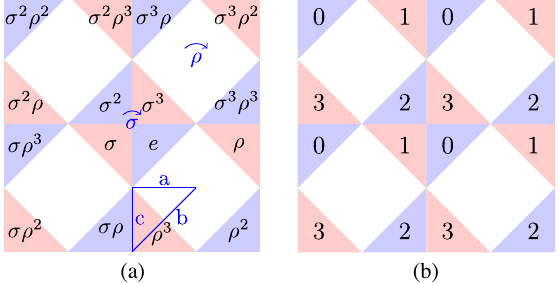
FIG. 25. An L ¼ 2 subsystem surface code. (a) After associat- ing a triangle operator with the identity element e , every triangle operator is in one-to-one correspondence with an element of the proper symmetry group G H þ 4 of the tessellation. In blue we label a ; 4 fundamental triangle with sides a , b , and c , as well as the rotations ρ ¼ ab and σ ¼ bc . (b) Each triangle operator can be labeled with an element of the cyclic group Z 4 using the to Z 4 . homomorphism h ð ρ Þ ¼ h ð σ Þ ¼ 1 from G H þ 4 ; 4